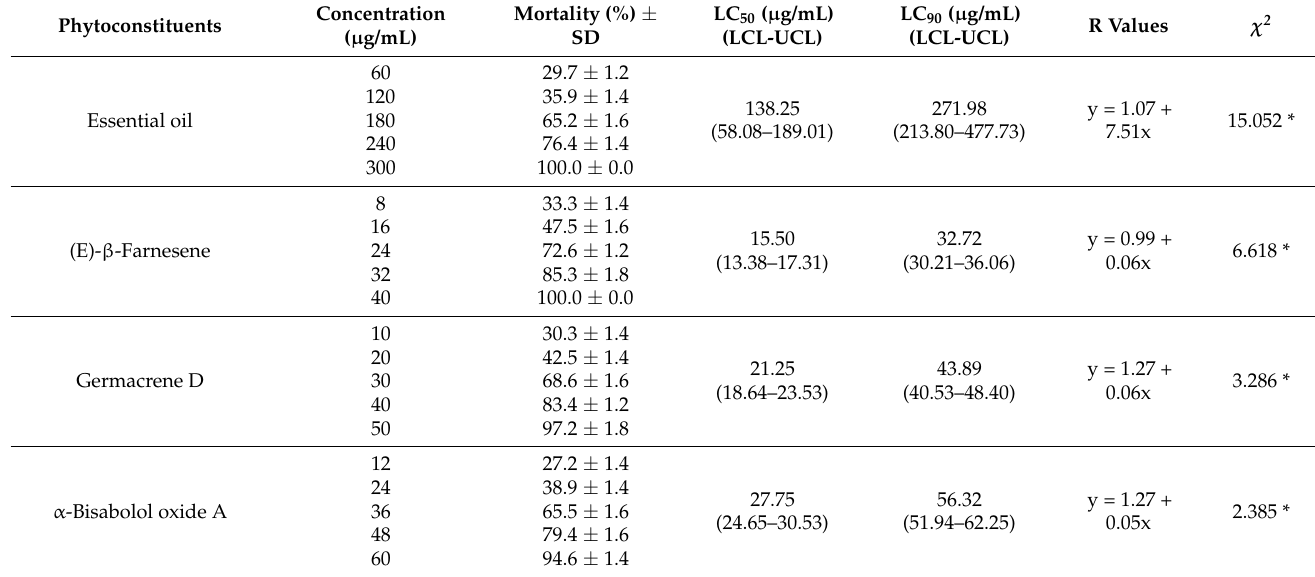
Table 3. Larvicidal activity of Matricaria chamomilla essential oil and its major phytoconstituents against 3rd-instar larvae of Helicoverpa